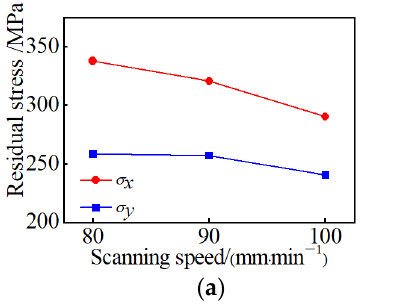
( d ) ( e ) Figure 13. Residual stress at different scanning speeds: ( a ) Test point A; ( b ) Test point B; ( c ) Test point C; ( d ) Test point D; ( e ) Test point E. 4.7. Influence of Scanning mode on Residual Stress Figure 14 shows the change of the residual stress on the surface of the sample by plasma cladding, when the working current is 95 A and the scanning speed is 100 mm/min. The plasma cladding samples are carried out by long-edge scanning, long-edge reciprocating scanning, and short-edge reciprocating scanning, respectively. It can be seen from the figures that the residual stress under the successive scanning mode is greater than that under the reciprocating scanning mode. The residual stress of short-edge scan- ning is greater than that of long-edge scanning. The law is consistent with the simulation results. Therefore, long-edge reciprocating scanning is the best scanning mode.